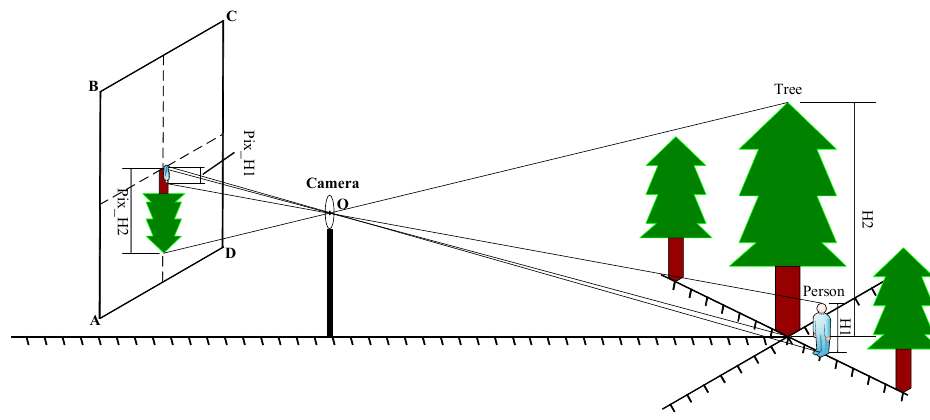
Figure 6. Schematic diagram of the person–tree scale height measurement model.